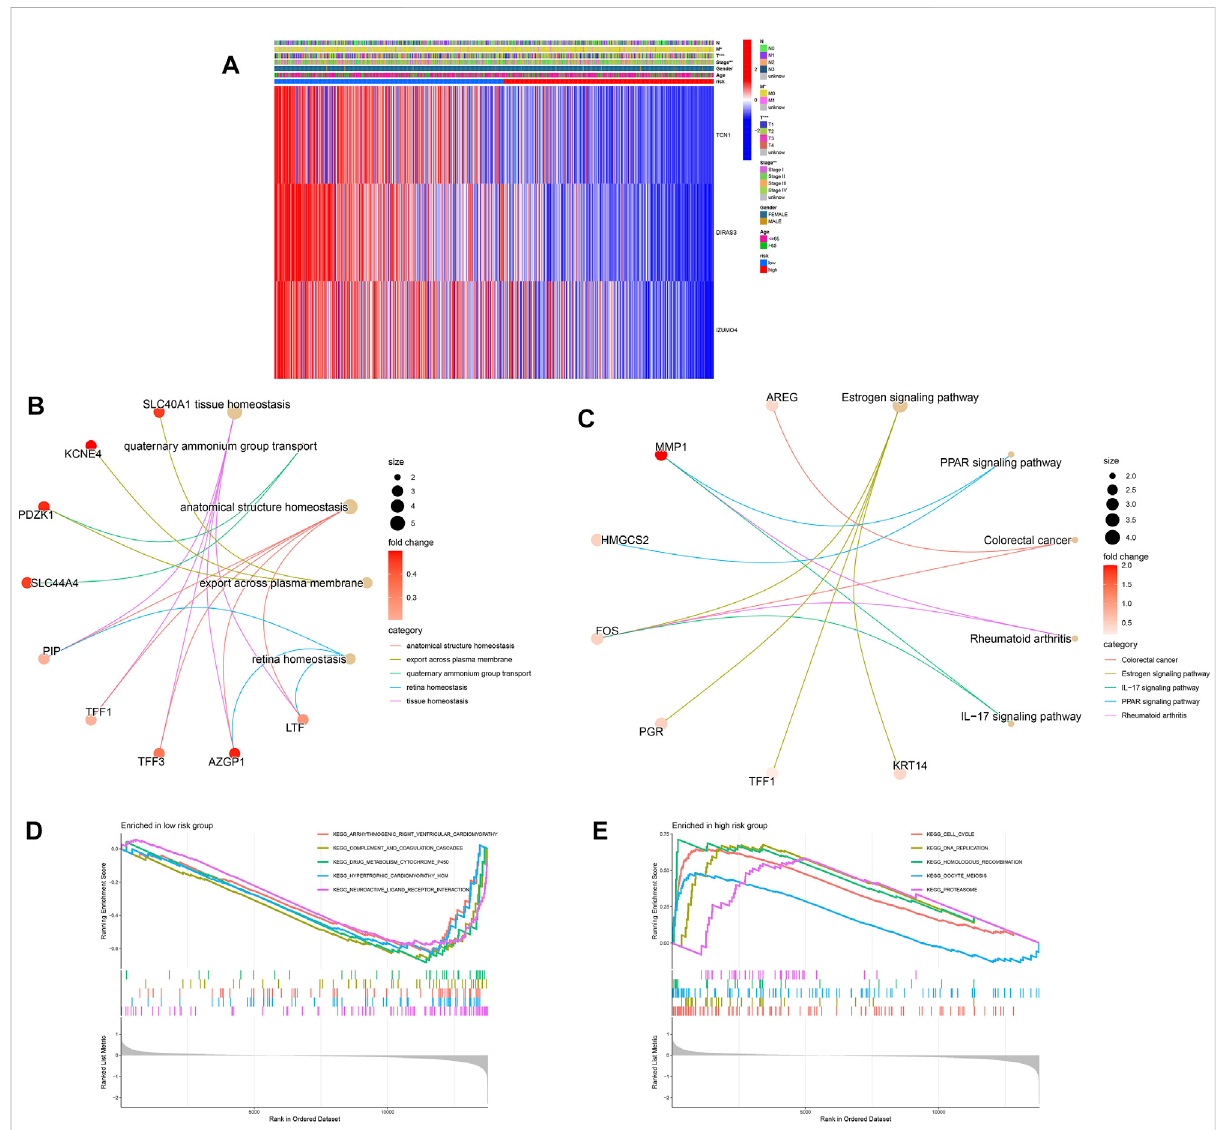
FIGURE 6 Relationship between clinical features and gene expression in high- and low-risk groups. (A) Heatmap of the two clusters along with clinicopathological characteristics and differentially expressed genes. (B,C) GO and KEGG analyses of differentially expressed genes between high- and low-risk groups. (D,E) Gene set enrichment analysis in the low-risk (D) and high-risk (E)